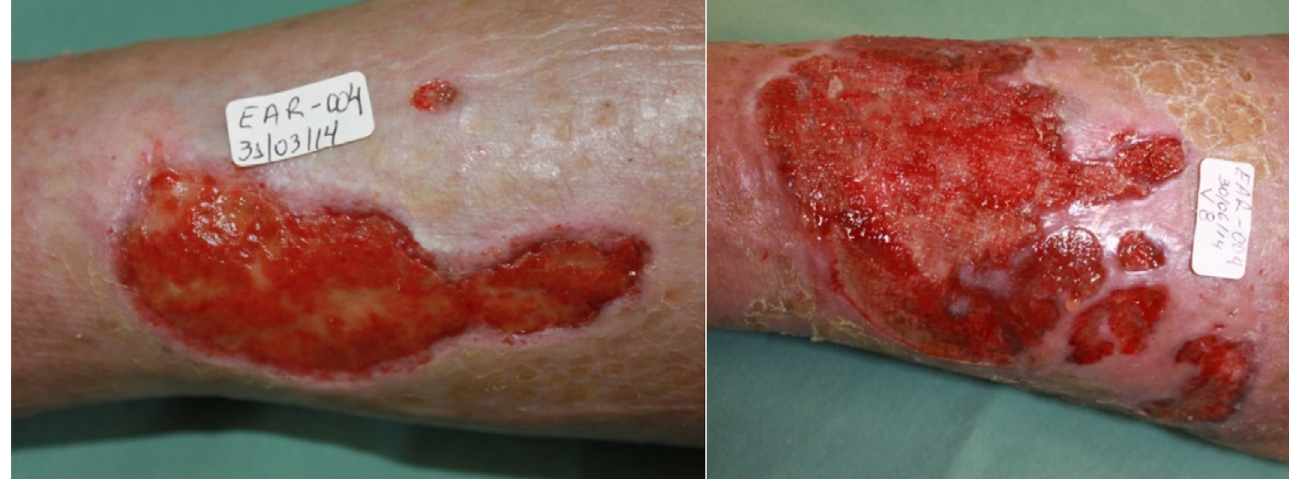
Figure 5. Female patient aged 76 years and carrier of one VU for three years. Initial ulcerated area was 25.4 cm 2 , area at the final visit was 52.0 cm 2 (increasing from initial ulcer area and opening of new